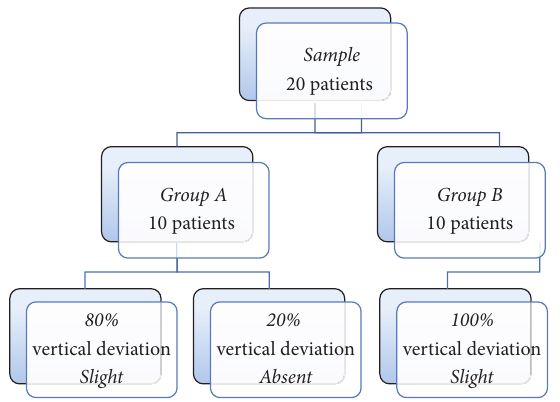
Figure 3: Follow-up at 1 month after operation.